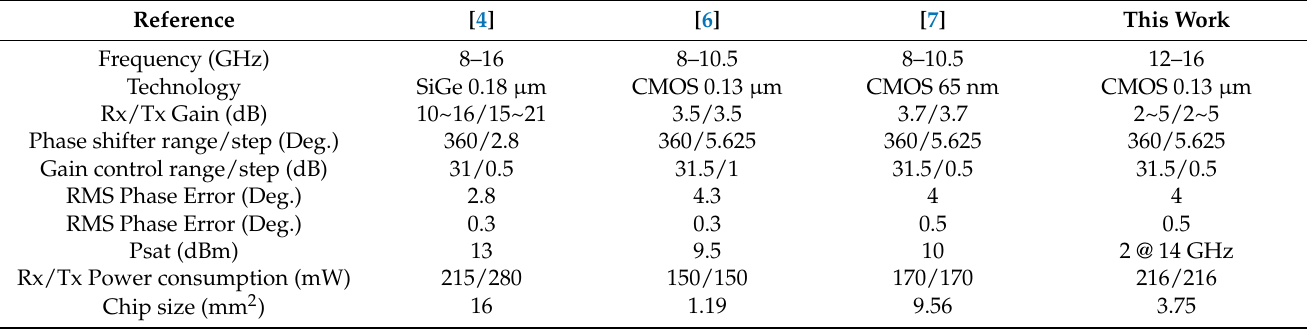
Table 2. Performance comparison of the relevant silicon-based transmit and receive